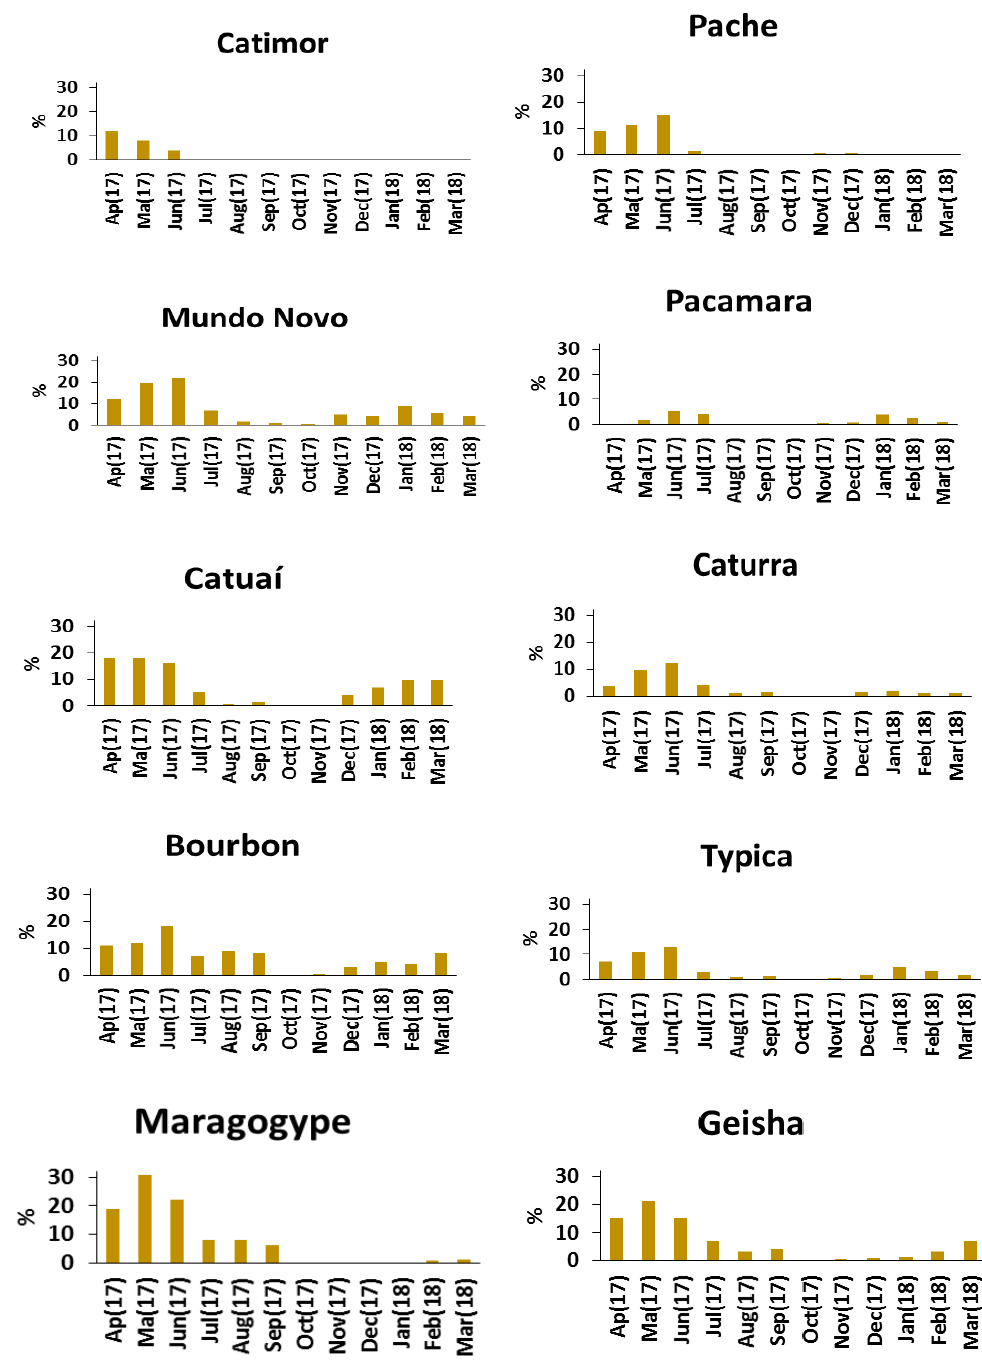
Figure 2. Co ff ee Leaf Rust dynamics, in each cultivar, from April 2017 to March 2018, in the lower